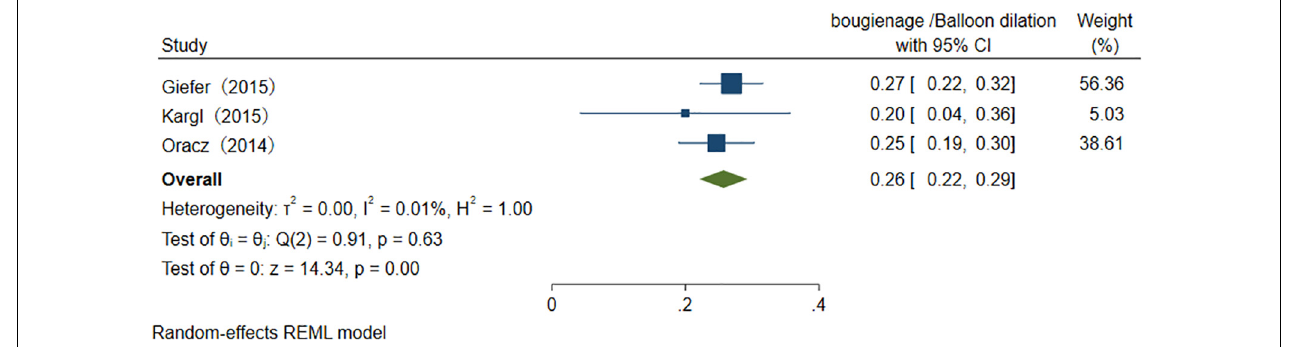
FIGURE 12 | The usage rate of bougienage/Balloon dilation.